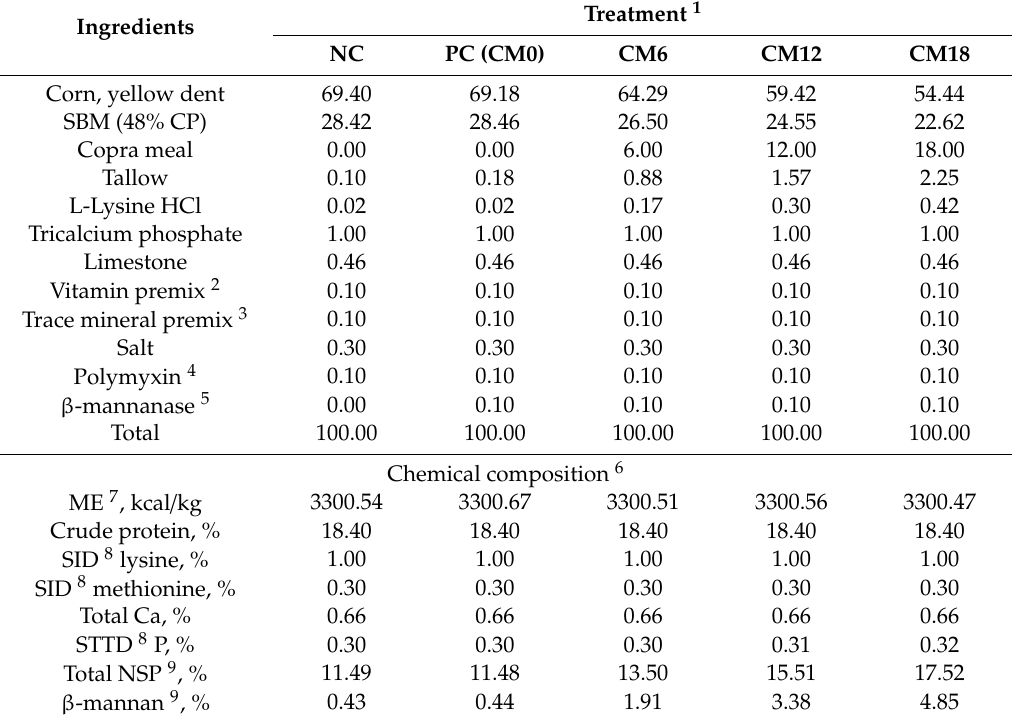
Table 2. The formula and chemical composition of experimental diets in growing